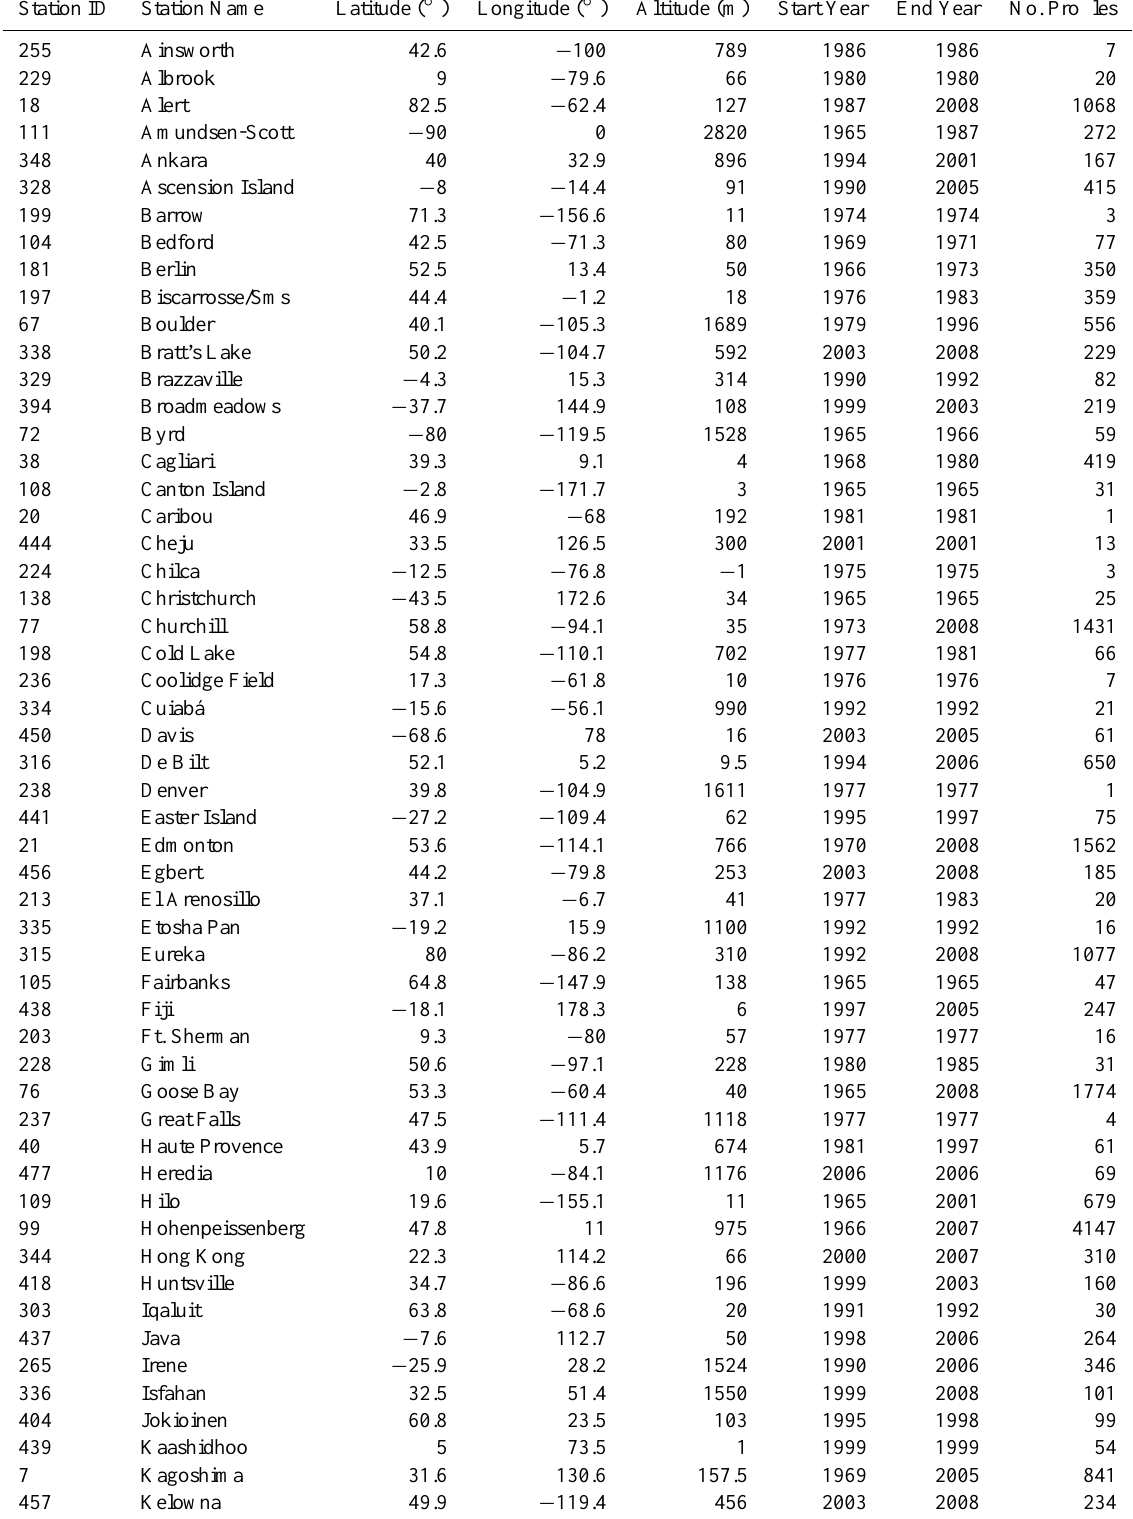
Table 1. Ozonesonde stations, including each station’s ID number, geolocation, the number of profiles used in this study, as well as measure- ment